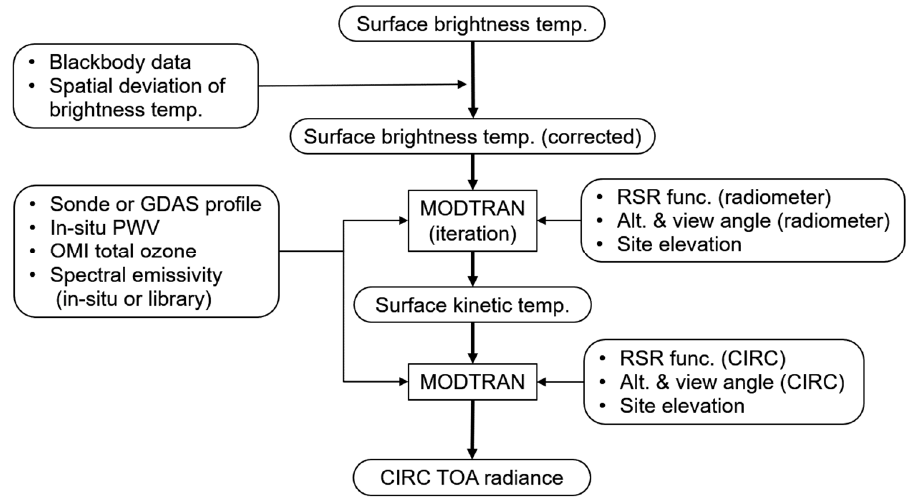
Figure 5. Processing flow of the top-of-the atmosphere (TOA) radiance estimation in Exp-VC. In Exp-VC, ALOS-2 / CIRC was often scheduled to observe the test site overlappingly. If the site was overlappingly observed by ALOS-2 / CIRC, all images including the site were used for Exp-VC. Actually, one to four images were used in Lake Kasumigaura, and ten or eleven images were used in Railroad Valley Playa. As for CALET / CIRC, such overlapping observation was not scheduled.